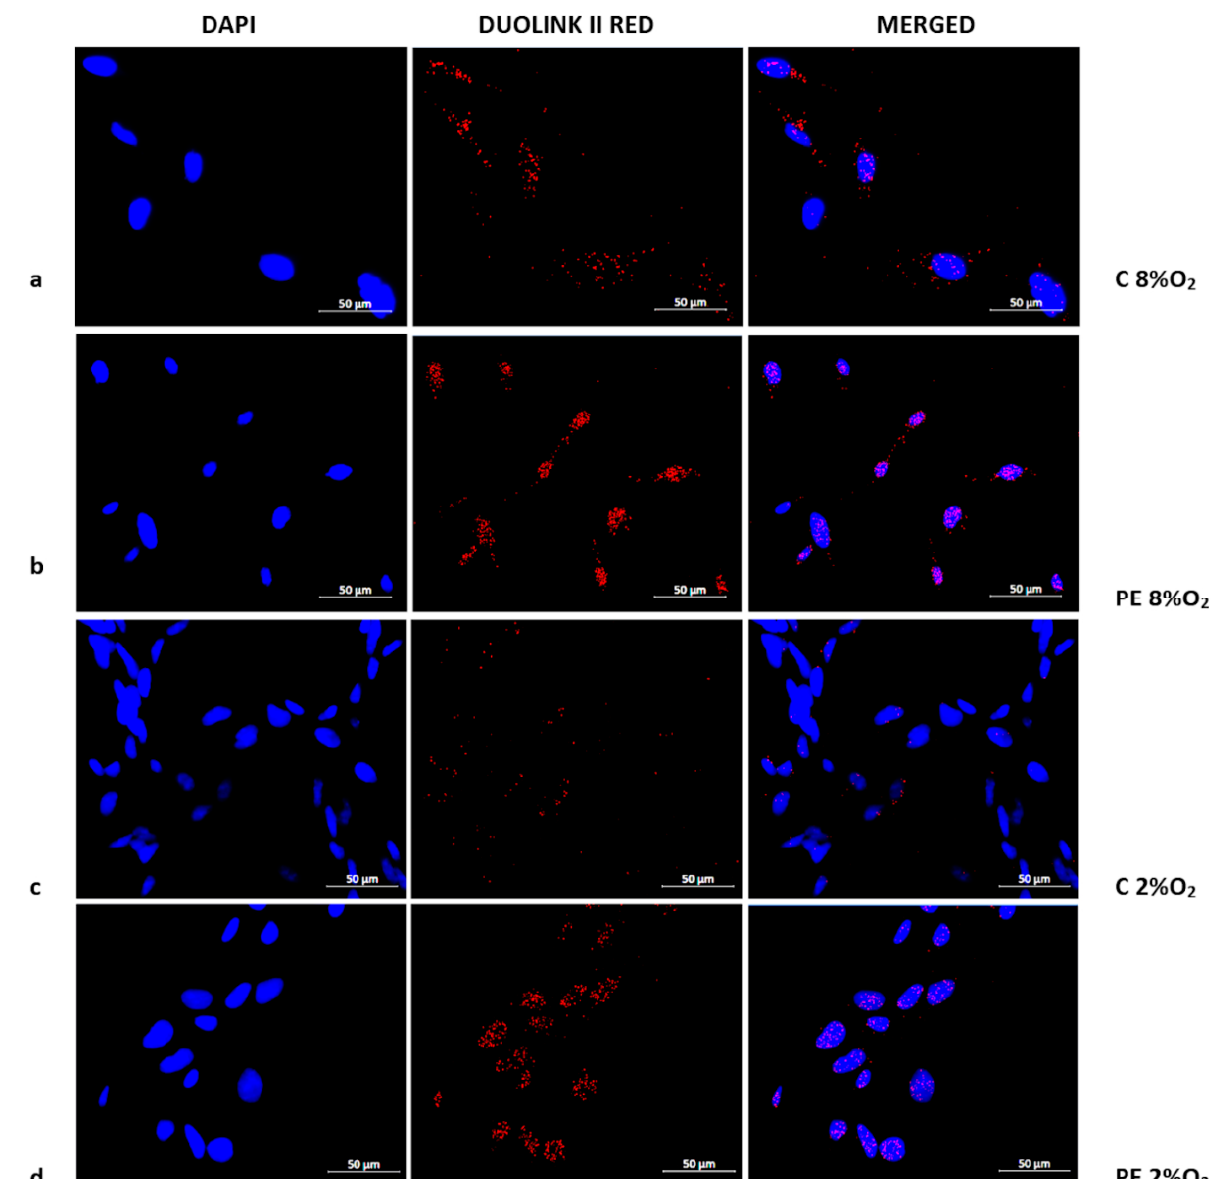
Figure 3. Duolink II PLA assay results for HTR8/SVneo cells cultured in normoxic and hypoxic conditions in medium containing 1% serum from preeclamptic ( b , d ) or normotensive ( a , c ) women. Each p53/RSK1 complex in HTR8/SVneo cells is visualised as an individual fluorescence red spot, nuclei were labelled with DAPI. Red spot – complex of p53/RSK1; blue spot – nucleus of cell. Magnification 40×; scale bar 50 μ m.